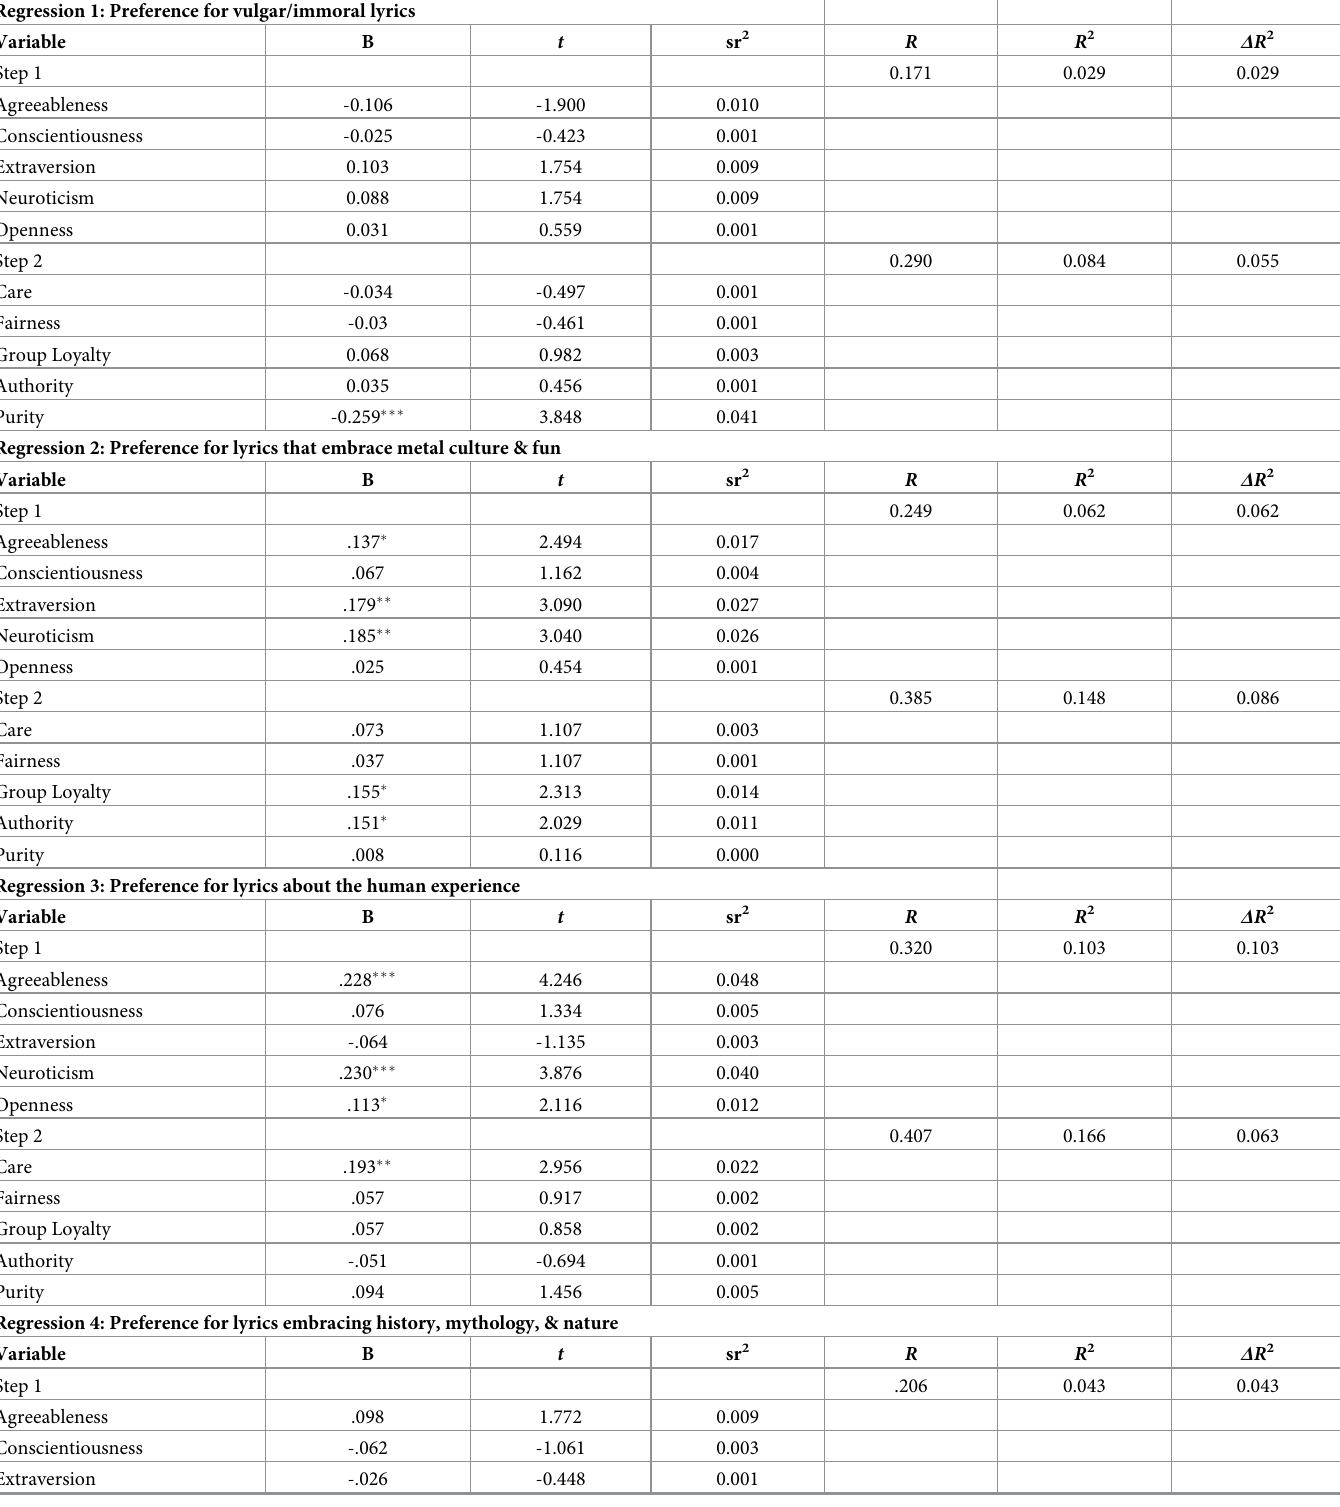
Table 6. Summary of hierarchical regression analyses for variables predicting lyrical prefrences